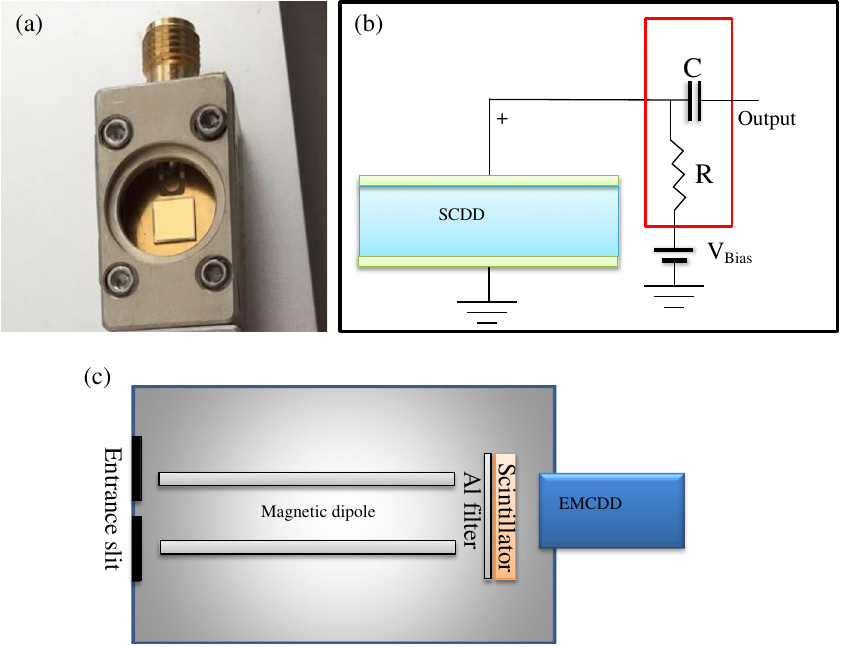
FIG. 2. Photo (a) and electrical scheme (b) of the SCDD detector, and sketch of the magnetic spectrometer (c) used during the